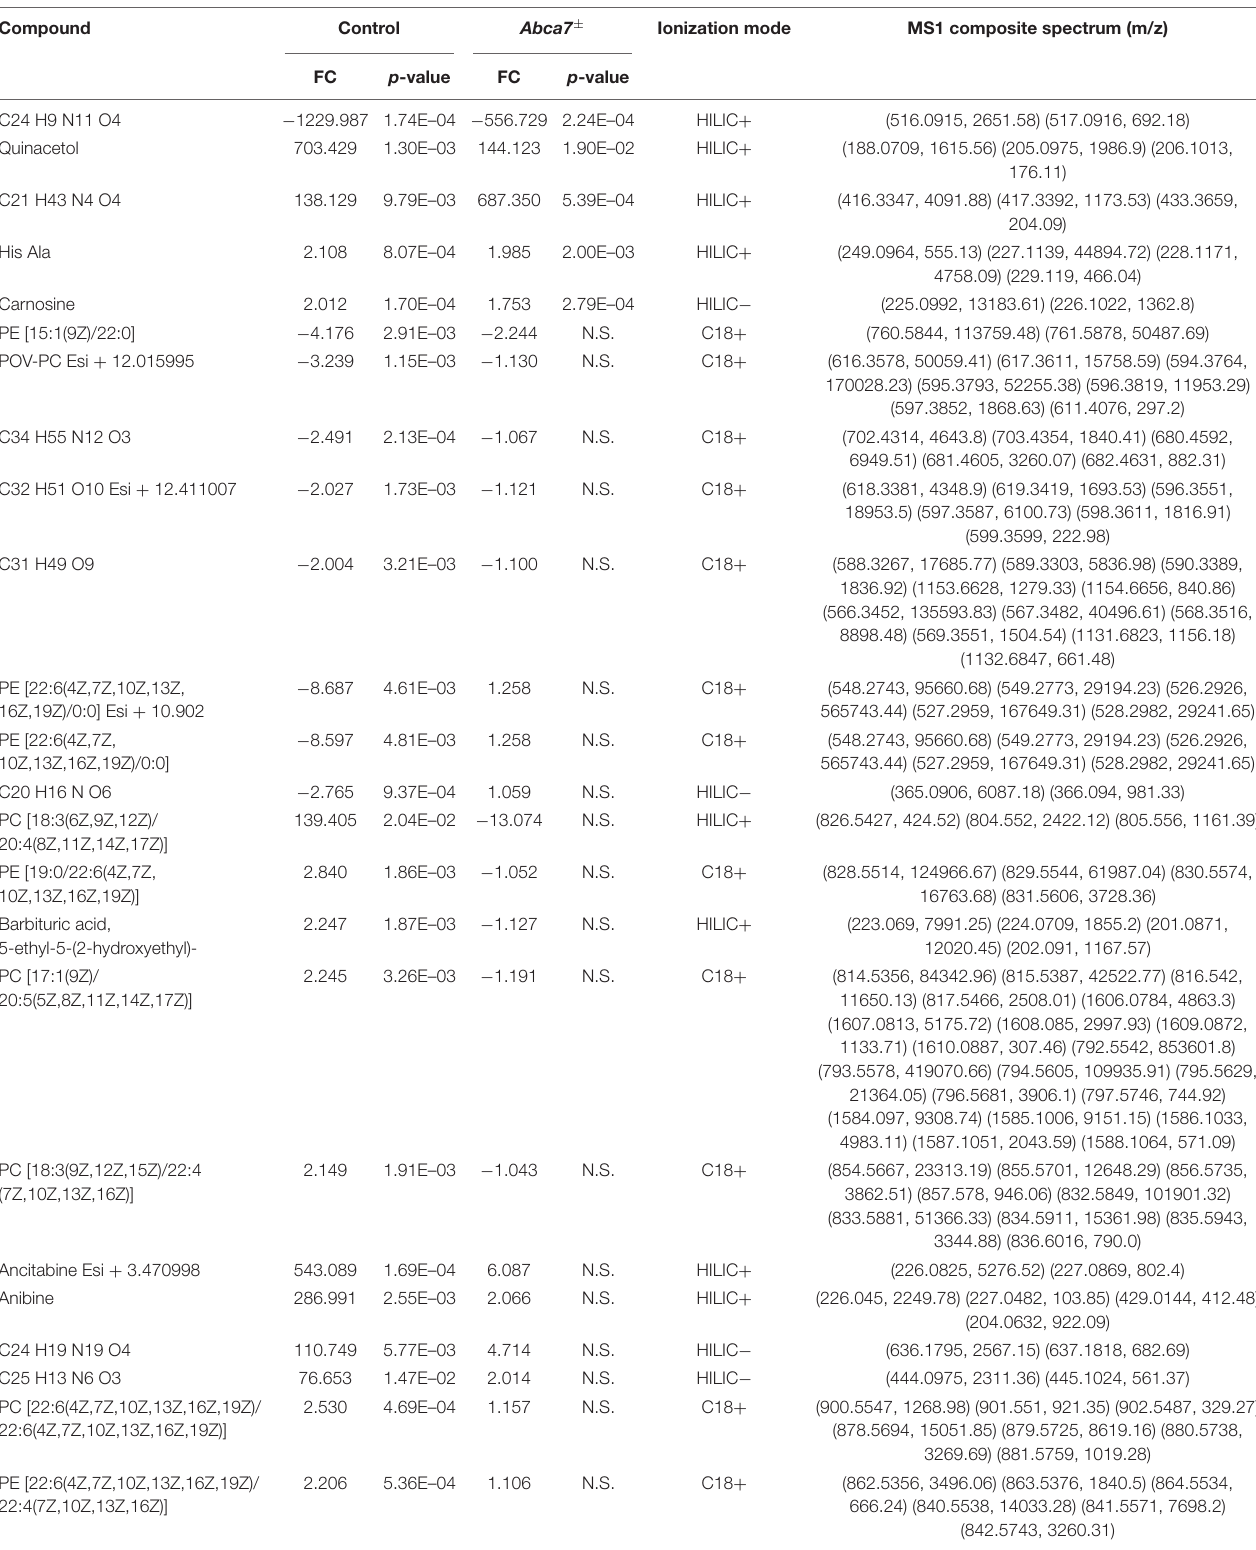
TABLE 1 | Metabolites affected by LPS administration in the mouse brains.